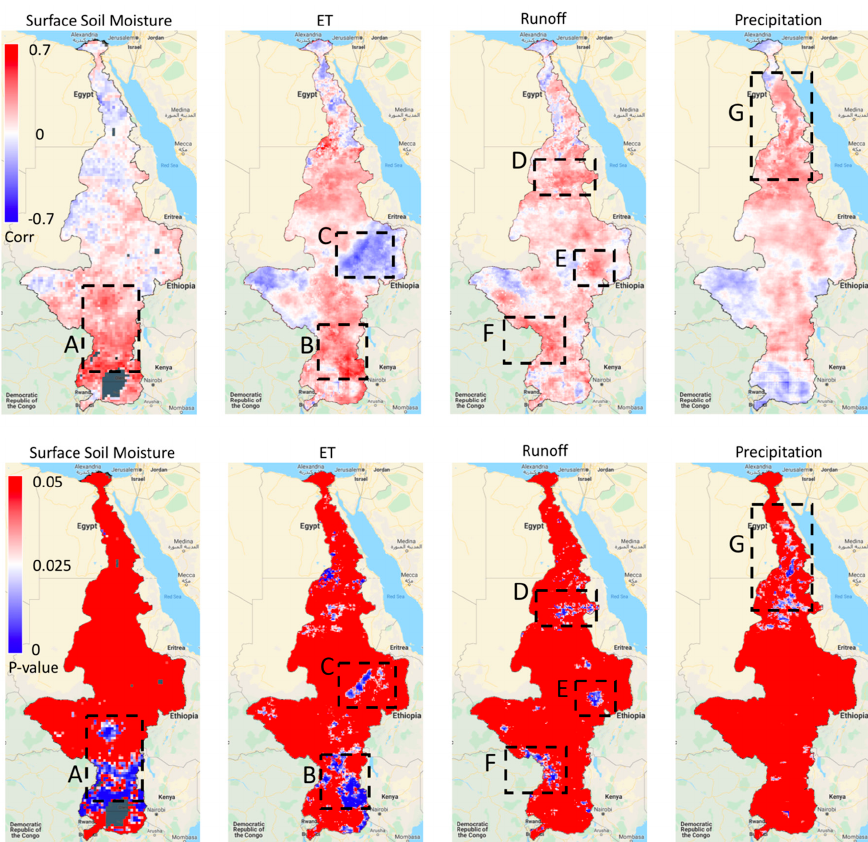
Figure 4. The correlation maps (correlation coefficient) between monthly anomalies values of LWE and other hydrological factors (precipitation, ET, surface soil moisture, runoff) over the Nile watershed (first row); and their p-value maps (second row). The values are calculated based on Pearson correlation analysis of the periods between the years 2002–2017 (2010–2017 for surface soil moisture). The regions A–G are the areas with low (< 0.05) p-values.